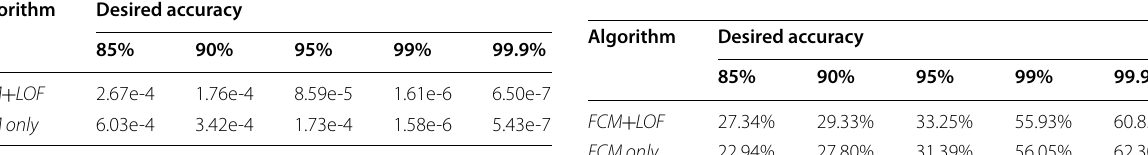
Table 1 Change rate of objective function with different desired accuracies